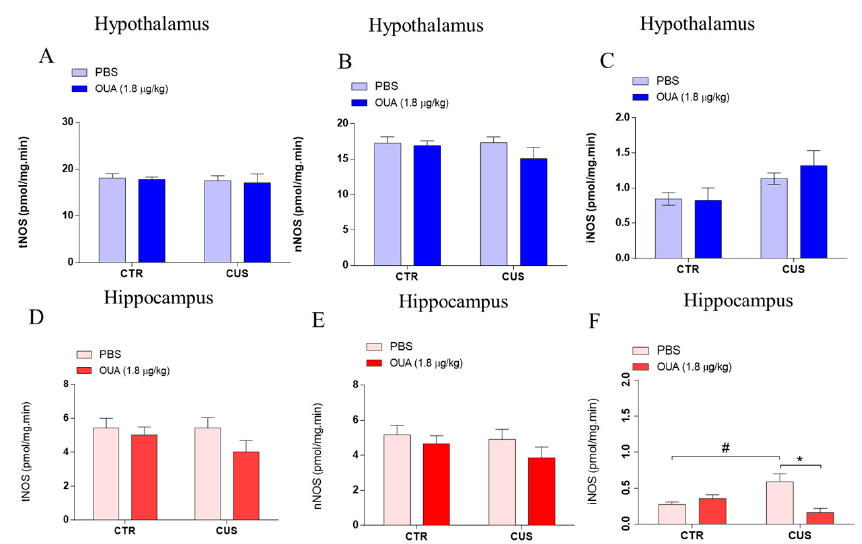
Figure 4. Chronic intermittent treatment with ouabain reduces iNOS activity in the hippocampus of animals submitted to CUS. ( A – C ) The activity of tNOS (F (1, 15) = 0.3099; p = 0.5860 for CUS factor. F (1, 15) = 0.1208; p = 0.7330 for treatment factor), nNOS (F (1, 16) = 0.6990; p = 0.4154 for CUS factor. F (1, 16) = 1.475; p = 0.2421 for treatment factor), and iNOS (F (1, 16) = 6.753; p = 0.0194 for CUS factor. F (1, 16) = 0.3043; p = 0.5888 for treatment factor) were not altered in the hypothalamus of the different groups studied ( n = 5) (blue bars). ( D , E ) The graphs show that there was no change in NOS total (F (1, 16) = 0.7099; p = 0.4119 for CUS factor. F (1, 16) = 2.451; p = 0.1370 for treatment factor) and nNOS (F (1, 16) = 0.9158; p = 0.3528 for CUS factor. F (1, 16) = 1.991; p = 0.1774 for treatment factor) activity in the hippocampus of the different groups studied (red bars) ( n = 5). ( F ) CUS increased iNOS activity, relative to control groups that were reduced by OUA treatment in the hippocampus (F (1, 16) = 0.6989; p = 0.4155 for CUS factor. F (1, 16) = 5.871; p = 0.0276 for treatment factor), # p < 0.05 when compared with CTR x CUS, and * p < 0.05 when compared with CTR-CUS x CUS+OUA (red bars) ( n = 5). Results are presented as mean ± SEM (a two-way ANOVA, followed by Newman– Keuls post hoc test, revealed a